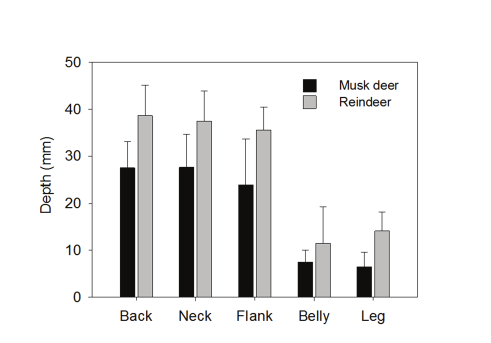
Figure 3. Mean fur depth (±SD). Pooled values for two musk deer (MD/1: male, 5 mo.; MD/2: female, 41 mo.) and two adult female reindeer (mean, SD). See Fig. 1 for further